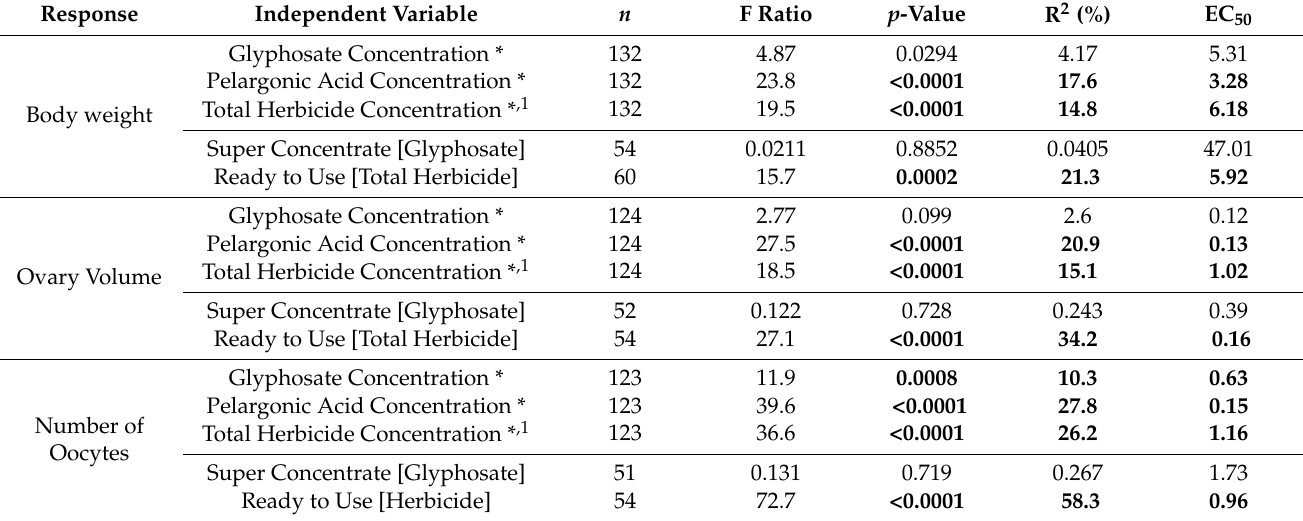
Table 3. Linear regression analysis of body weight, ovary volume, and number of oocytes on glyphosate, pelargonic acid, and total herbicide concentration, and for each Roundup ® formulation (Bivariate Fit). Regression coefficients (R 2 ) and 50% Effective Concentrations (EC 50 , concentration required to induce a 50% reduction in each variable measured) are only meaningful if p is significant. Significant p -values after Bonferoni correction ( p < 0.003) and corresponding R 2 and EC 50 shown in bold. * Includes unexposed controls where concentration = 0. 1 Sum of glyphosate concentration and pelargonic acid concentration.